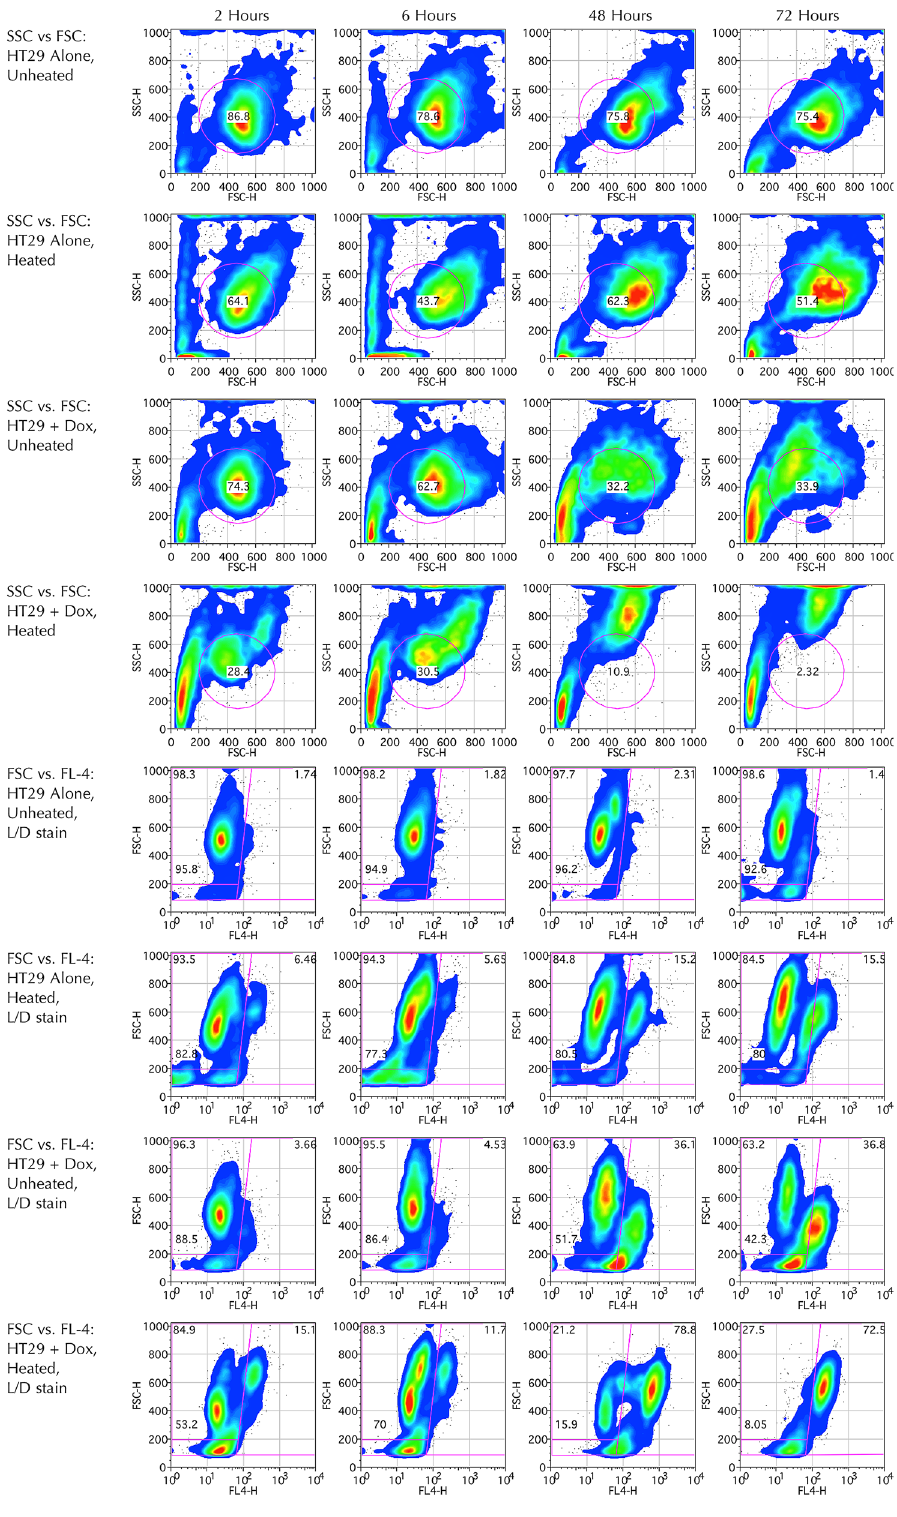
Figure 4. Flow cytometric studies of HT29 cell suspensions with and without 100 µg/g doxorubicin exposure and/or 30 min of 47 °C hyperthermia. Viability analysis performed using L/D stain, assayed at 2, 6, 48 and 72-h (Columns 1–4). Rows 1–4: Side Scatter (SSC) vs. Forward scatter (FSC) with population of likely viable cancer cells selected by a circle, expressed percentage of all events centrally within the circle. No events discarded. Rows 5–8: FSC vs. far-red FL-4 channel (633/660 ± 16 nm) (see methods). 10,000 events recorded and events with FSC < 100 AU discarded, presumed to represent cell debris and/or impurities. Percentage of cell viability (top left) vs. death (top right) are demonstrated within the larger (outer) gated areas. The events within the viable cell gate with FSC between 100 and 200 AU are presumed to represent apoptotic bodies, and these have been excluded using a smaller sub-gate, with percentage of all events within that gate just above the FSC = 200 AU line. Plots generated using FlowJo Data Analysis